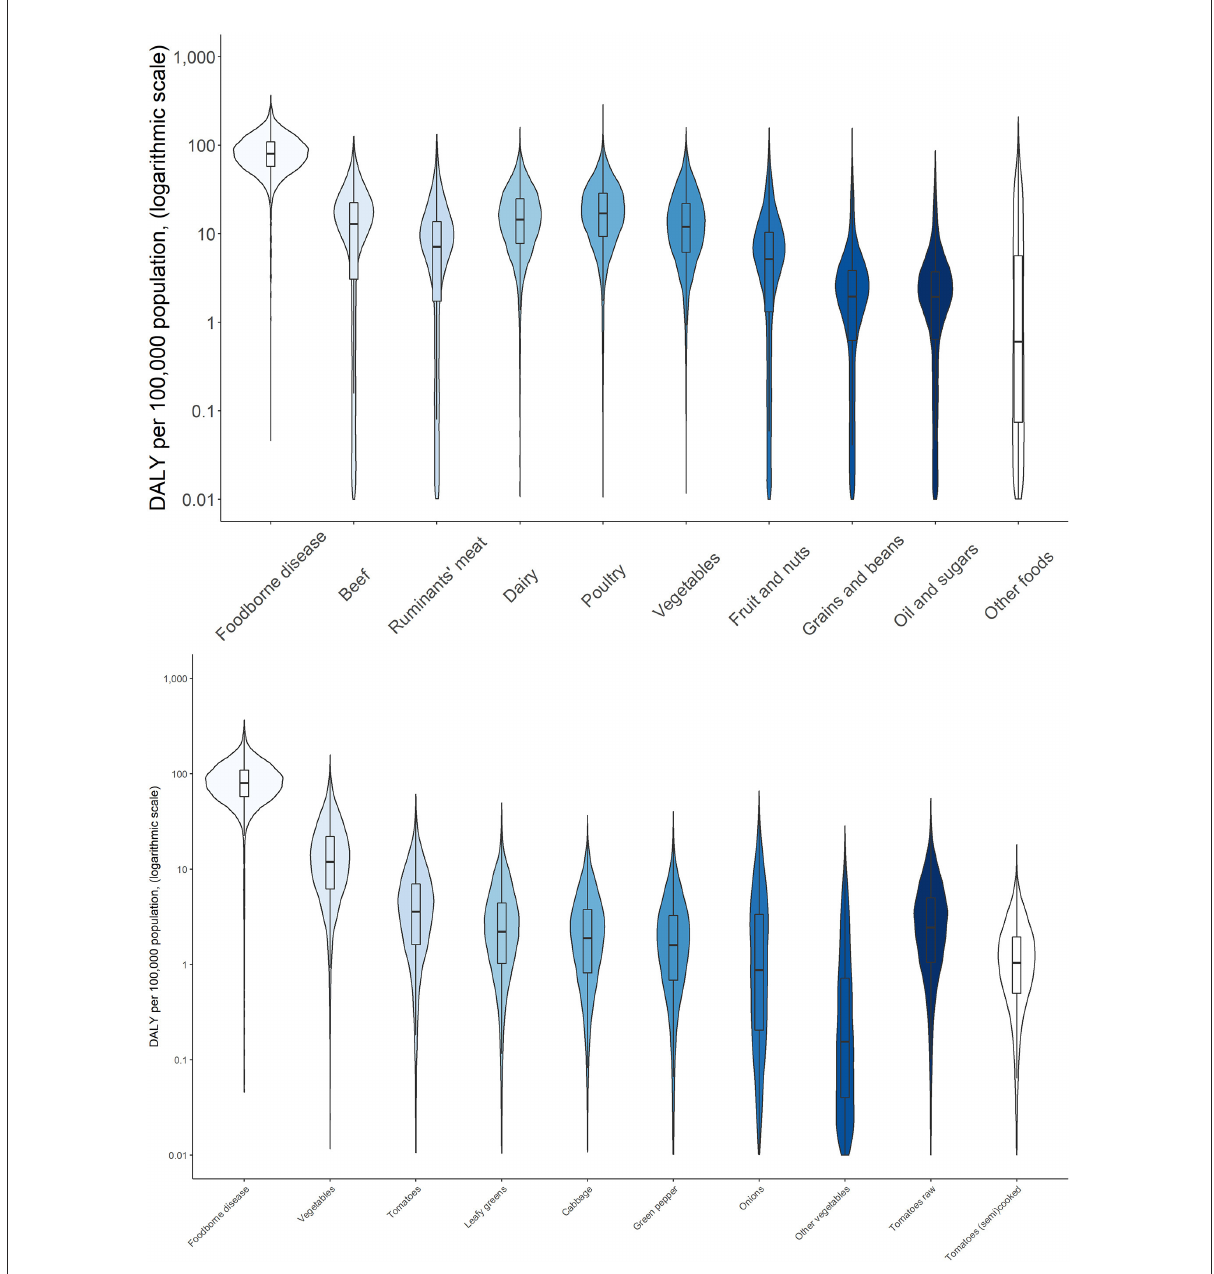
FIGURE7 Attribution of disease burden (Disability-Adjusted Life Years per 100,000 population) of enterotoxigenic E. coli to food group, food types and food products in Ethiopia in 2017. See Figure 1 for explanation of violin plots.